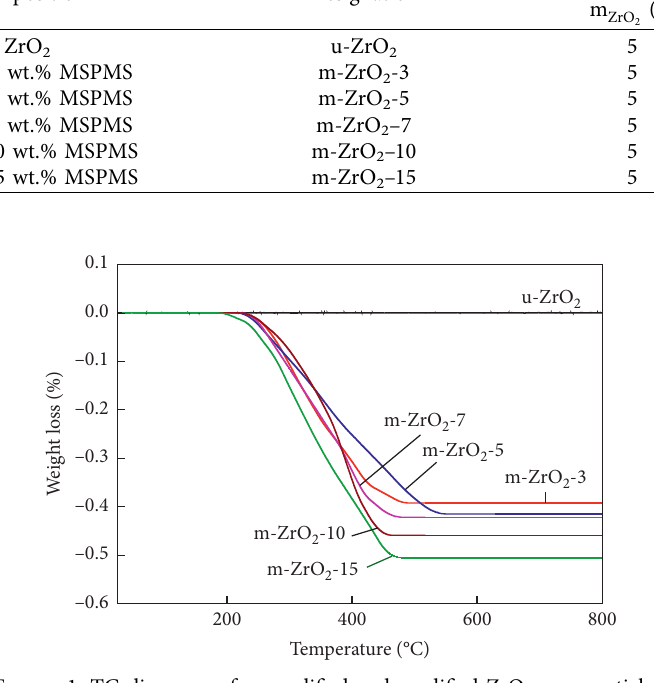
2 nanoparticles.